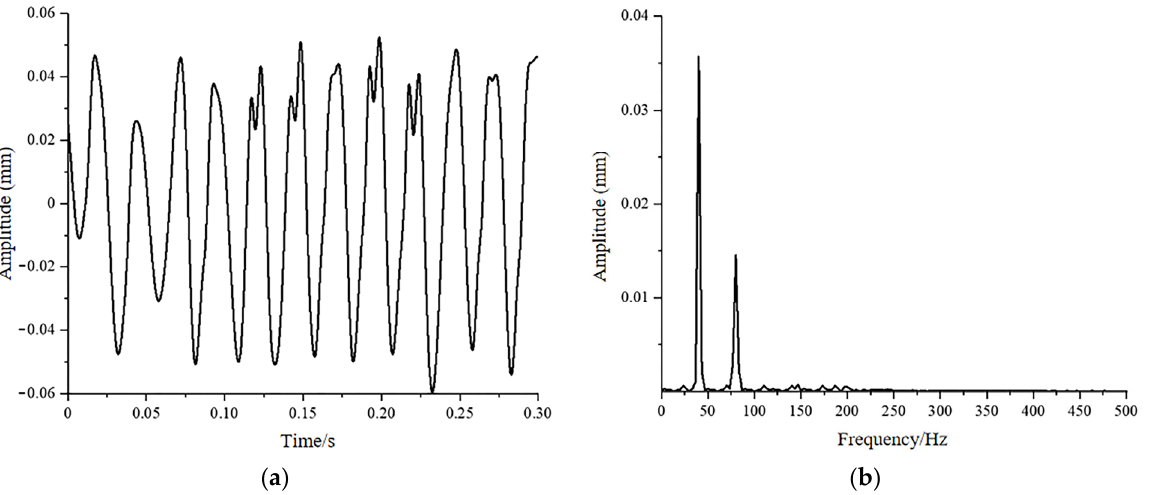
Figure 5. Recomposition of rotor misalignment fault signal. ( a ) Time-domain diagram ( b ) Frequency-domain diagram